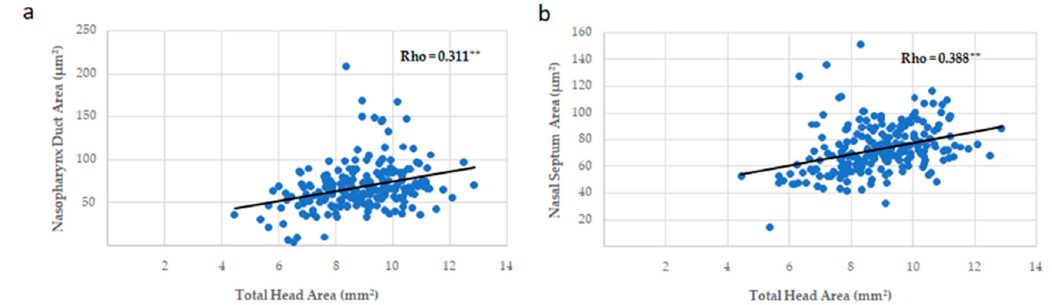
Figure 10. Correlations between nasal measurements and total head area. ( a ) Nasopharynx duct area and ( b ) nasal septum area. ** p ≤ 0.01; Spearman’s Rho.